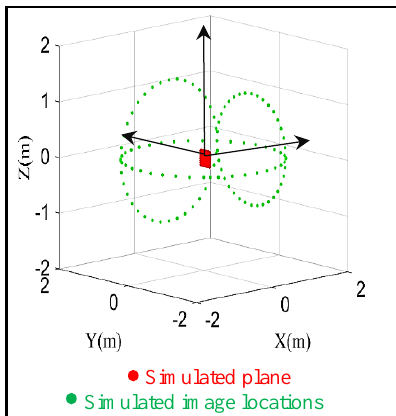
Simulated plane Simulated image Figure 4. Simulated image network (108 images) arround a simulated planar object